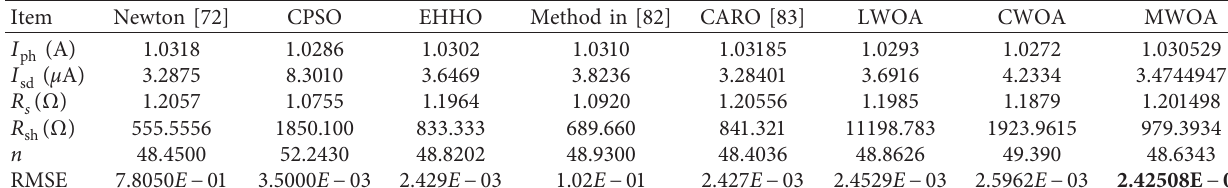
Table 6: Identification results of PV module model based on eight algorithms.